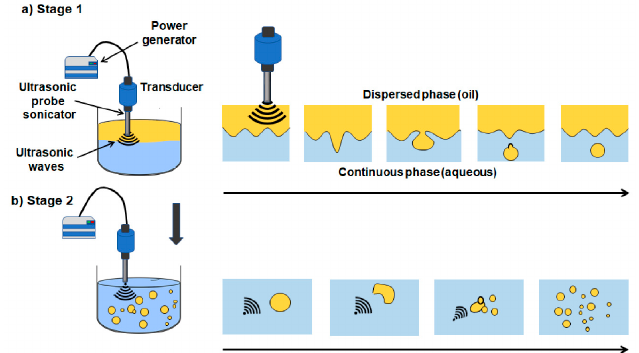
Figure 15. Schematic representation of ultrasonic emulsification. ( a ) The shear forces generated during acoustic cavitation near the interface between the aqueous phase and oil phase promote the eruption of large oil drops (dispersed phase) in the continuous aqueous phase. ( b ) The oil droplets formed in the first stage are reduced to smaller droplets as a consequence of the shock waves generated during cavitation.